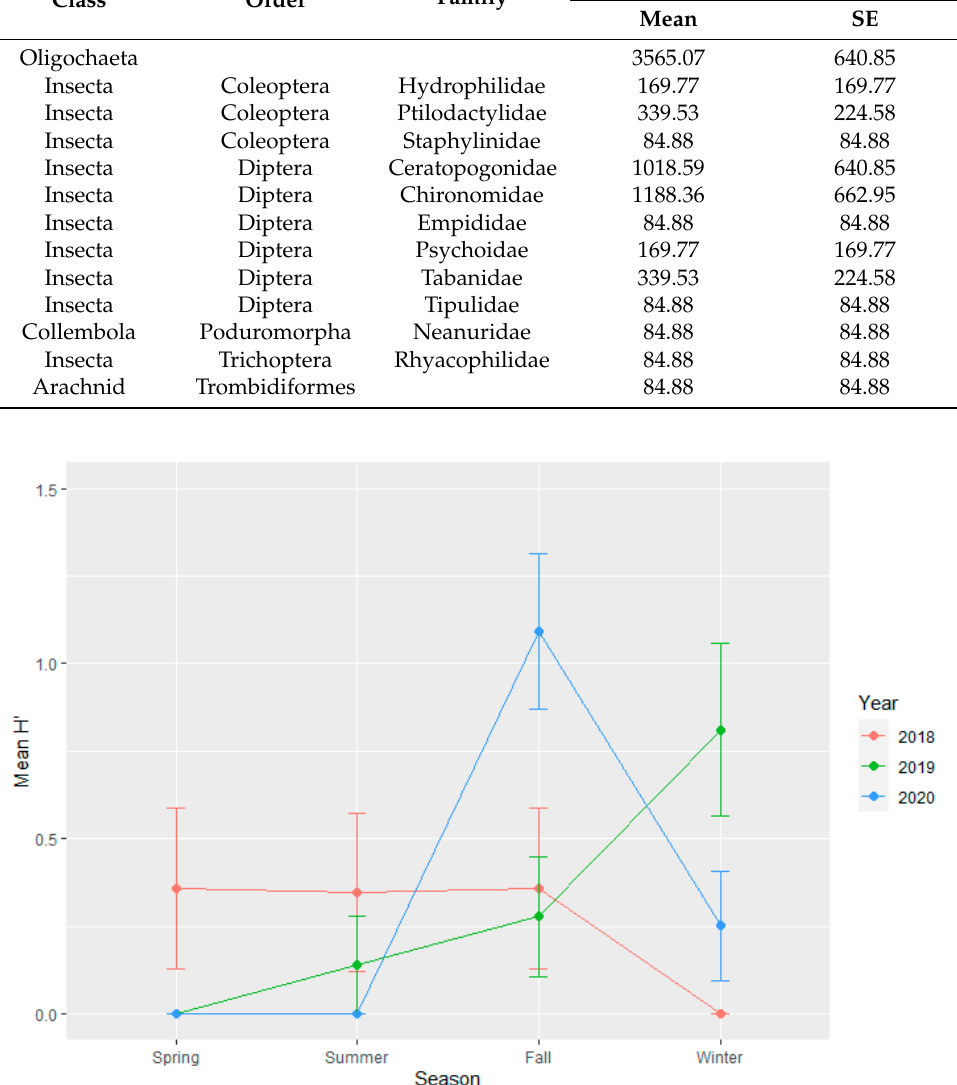
Figure 5. Seasonal variation in benthic macroinvertebrate Shannon diversity (H’) across five wetlands within the Ruby Run riparian zone at the J.W. Ruby Research Farm in Preston County, West Virginia, USA, during 2018–2020. Error bars indicate standard error for each mean value. Table 2. Benthic macroinvertebrate assemblages across five locations within the Ruby Run riparian zone at J.W. Ruby Research Farm in Preston County, West Virginia, USA, from 2018 to 2020. Relative abundance was calculated as number of individuals per square meter. All taxa were larval forms aside from Oligochaeta, which consisted of both adults and juveniles.